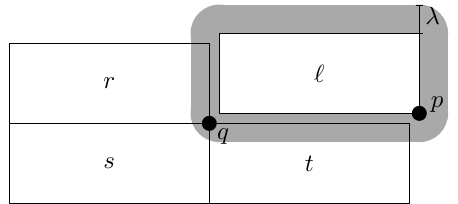
Figure 2. A point p with a label (cid:96) , which can be misinterpreted as the label for q , since q is within distance λ from (cid:96) . When labeling p with (cid:96) , the label for q can be r , s , or t